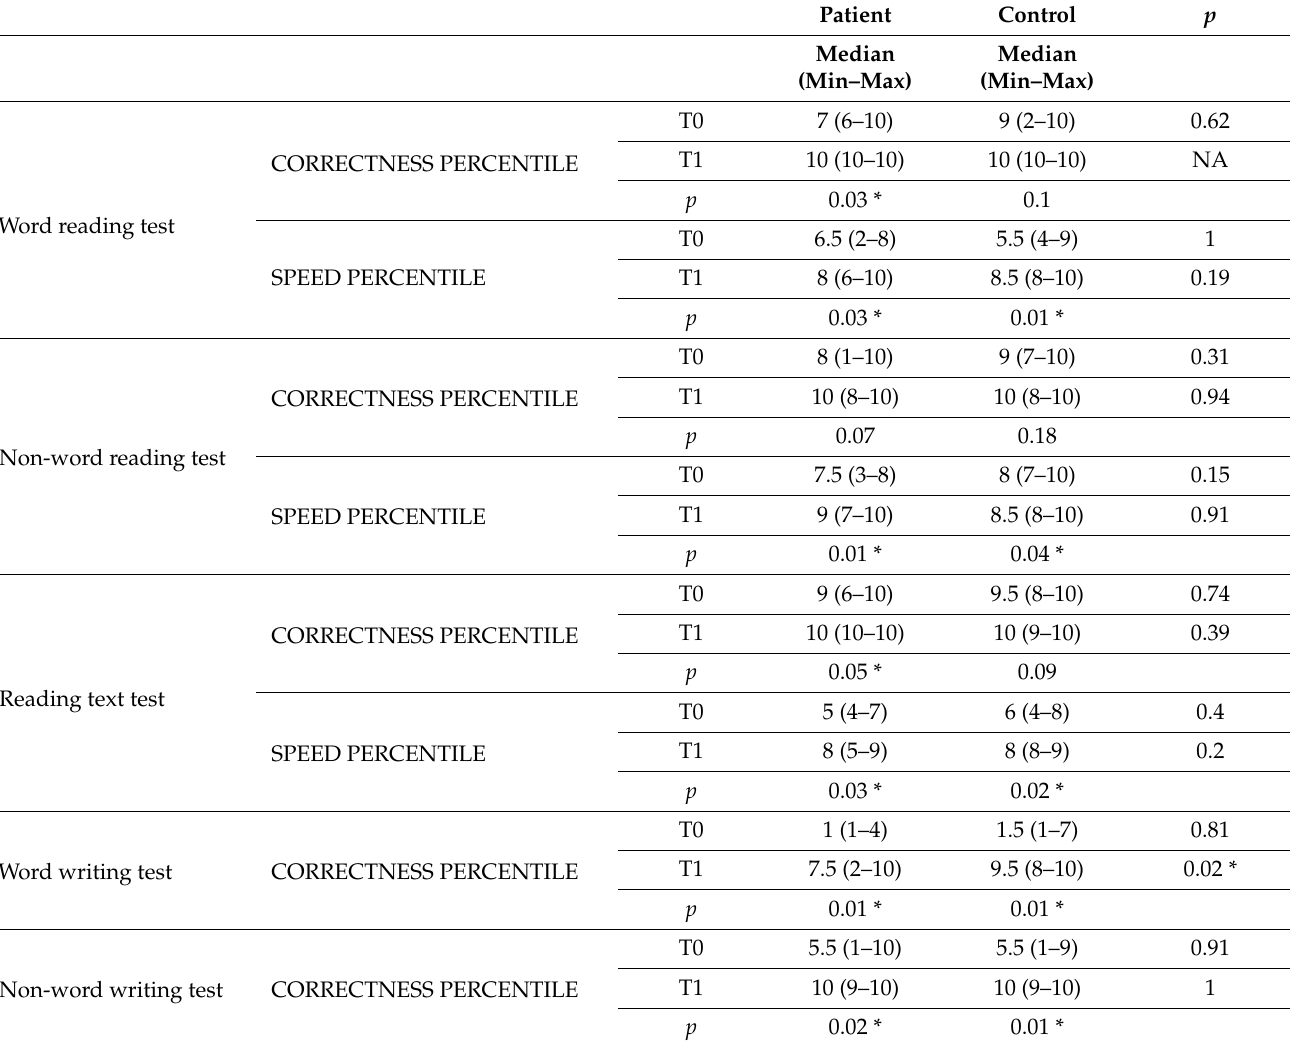
Table 1. Inter and Intra group